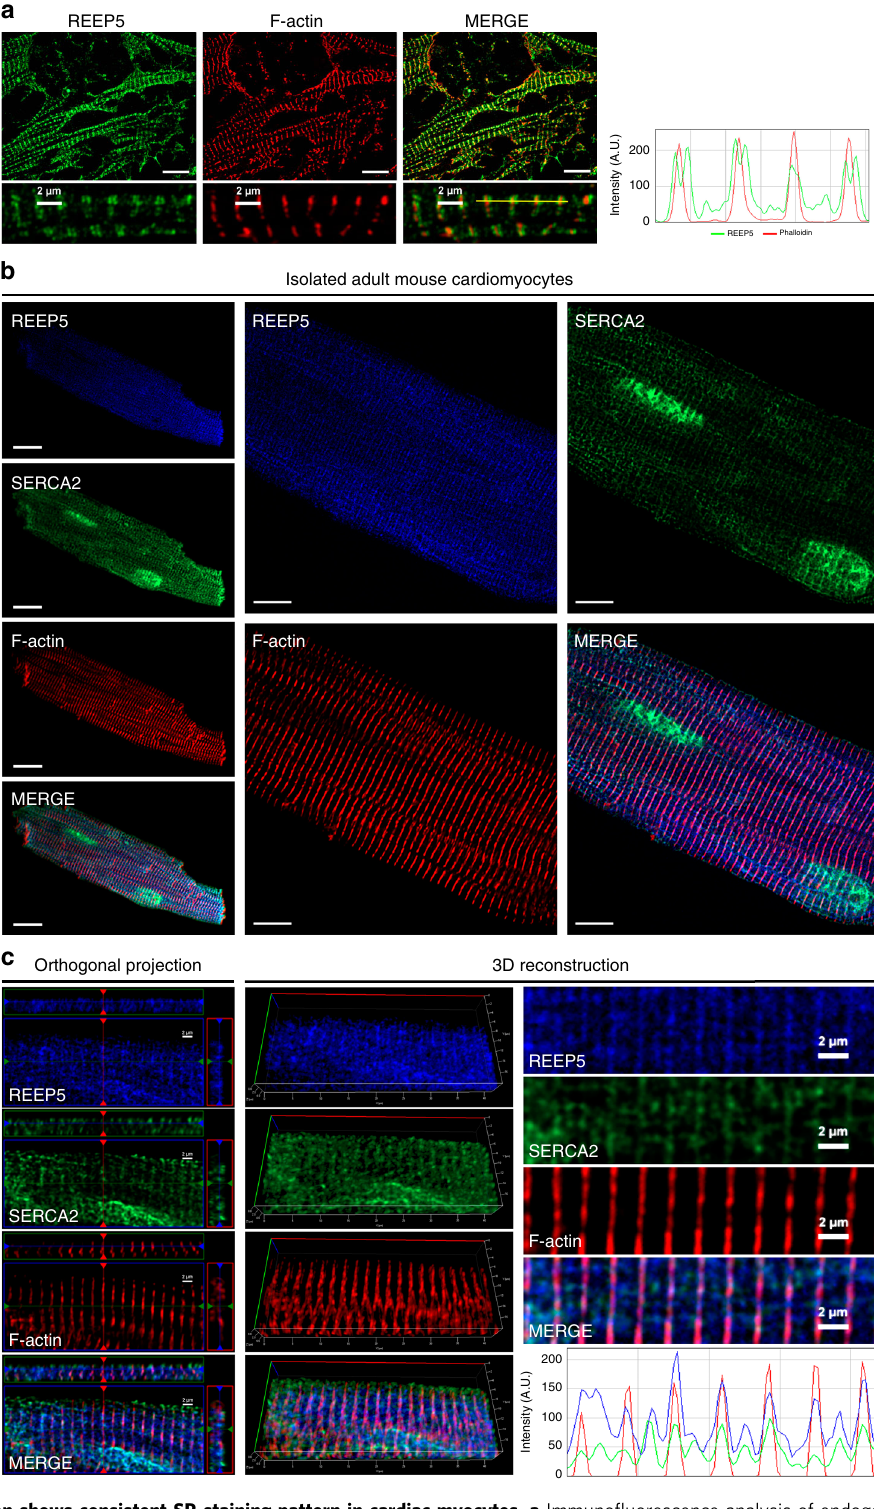
Fig. 2 REEP5 expression shows consistent SR staining pattern in cardiac myocytes. a Immuno fl uorescence analysis of endogenous REEP5 expression (green) and phalloidin-rhodamine staining (red) in CMNCs. Right panel, line-scan analysis (from yellow line) demonstrates SR expression pattern in CMNCs. Scale, 10 μ m. b Immuno fl uorescence of isolated adult mouse cardiac myocytes with REEP5 (blue) co-stained with SERCA2 (green) and phalloidin- rhodamine (red). Scale, 20 μ m (left panel), 10 μ m (right panel). c Orthogonal projection, three-dimensional reconstructive and line-scan analyses demonstrates co-localization between REEP5, SERCA2, and phalloidin signal. (Left panel): the top panels represent cell imaging in the x – z plane, while side panels represent cell imaging in the y – z plane. All images shown are representative of approximately 40 – 50 total images captured per condition, n = 3 independent biological